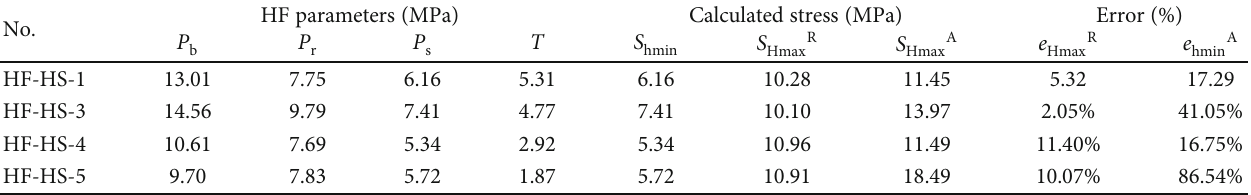
Table 4: Summary of the experimental stress measurement data and results based on the modi fi ed fracture mechanics methods. No.